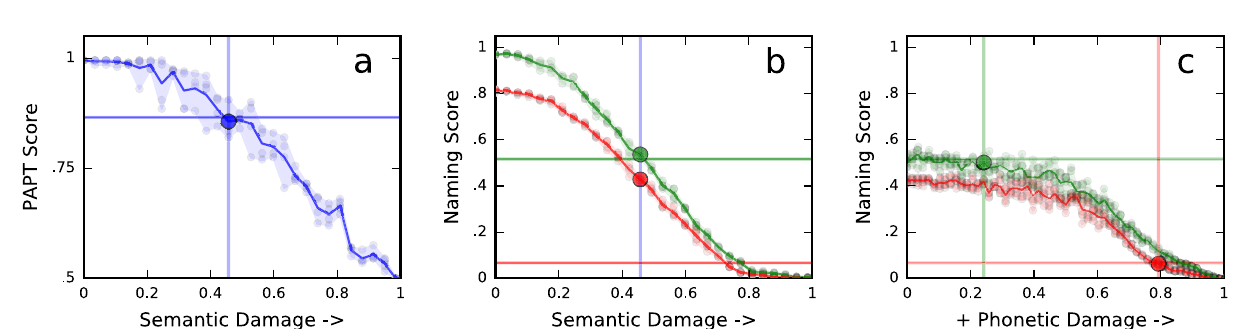
Figure 3. Adjusting the amount of damage to BiLex’s semantic and phonetic maps to match patients’ test scores (data for patient P8 are shown). ( a ) As lesion damage to the semantic map increases (left to right), the model’s semantic performance (PAPT score) decreases. The vertical line shows the amount of damage that best matches the target (horizontal line). ( b ) Semantic damage affects naming performance in both English (green) and Spanish (red). ( c ) Starting from the best-fit amount of semantic damage, additional lesion damage is applied to English and Spanish maps to match naming performance in both languages. As before, horizontal lines are the patient’s actual scores, and vertical lines are the best-fit amounts of lesion damage. The final lesion levels for semantic, English, and Spanish maps combine to reproduce the patient’s diagnostic scores in the